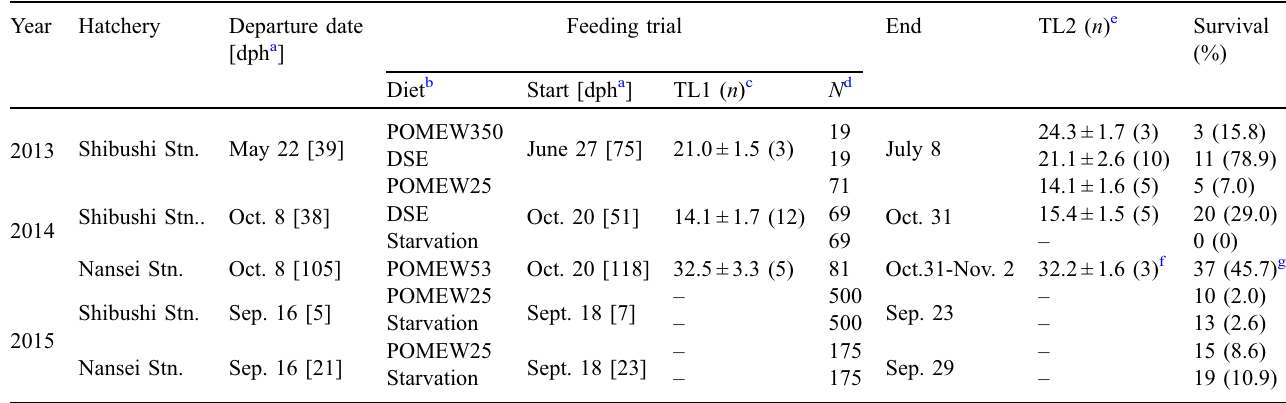
Table 1. Information of the Japanese eel, Anguilla japonica leptocephali used for feeding experiment on